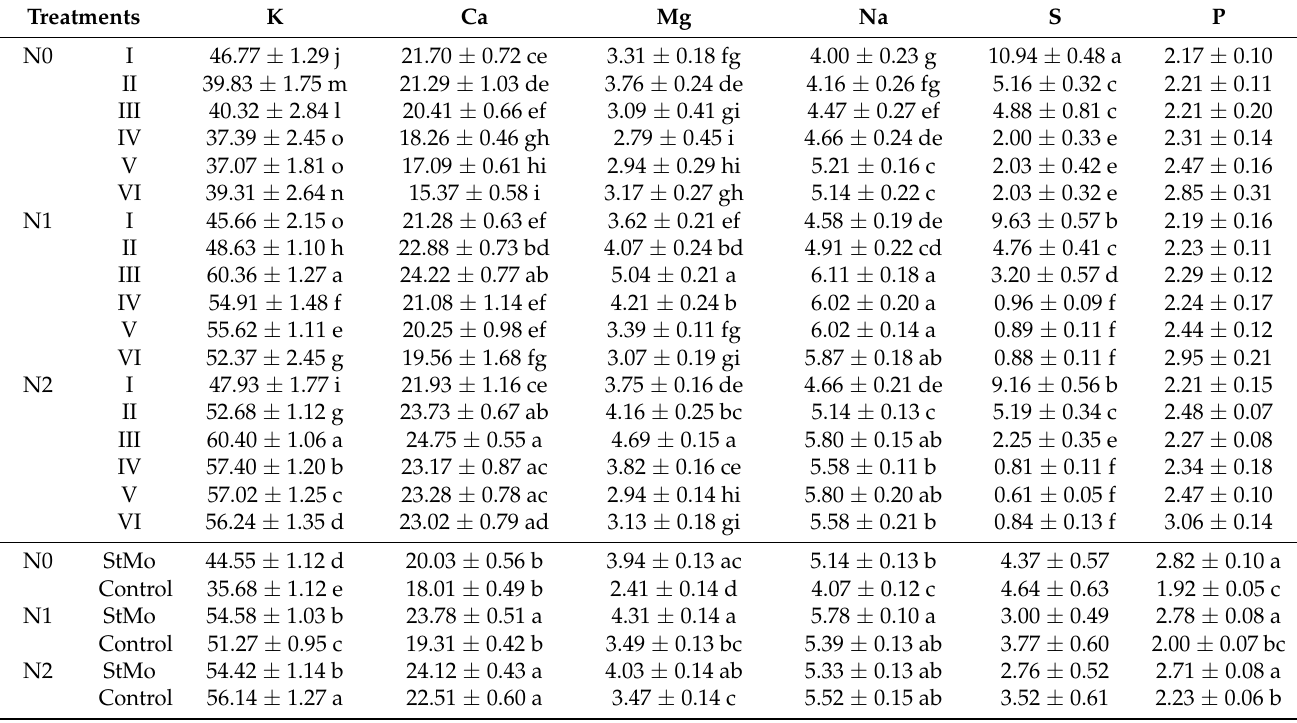
Table 5. Interactions nitrogen fertilization × harvest (F × H) and nitrogen fertilization × biostimulant (F × B) on the average mineral content of rocket (g kg − 1 dw). Different letters within each column indicate significant differences according at p = 0.05 (Tukey’s test).